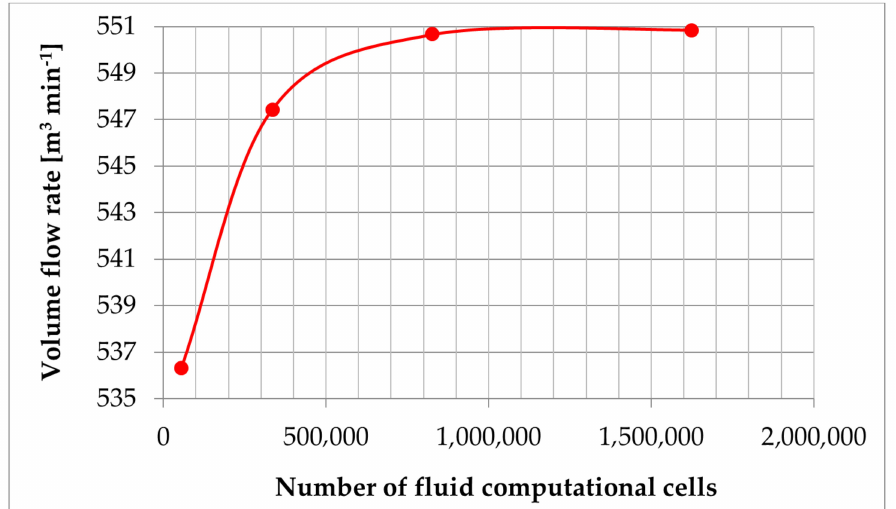
Figure 6. Convergence of results in the numerical grid refinement study. In additional, the 12 inflation layers were considered and located within the boundary layer of flow to properly resolve the boundary layer as was shown in Figure 7.